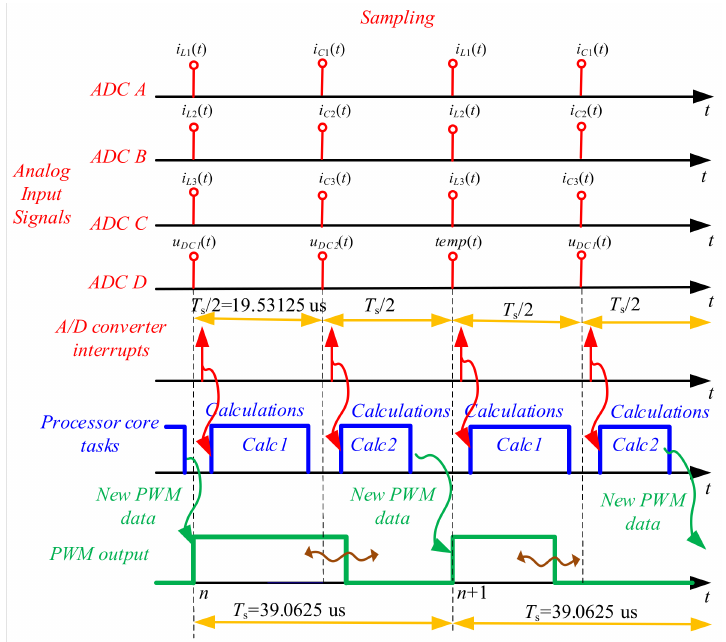
Figure 6. Timing diagram of data flow in the APF controls